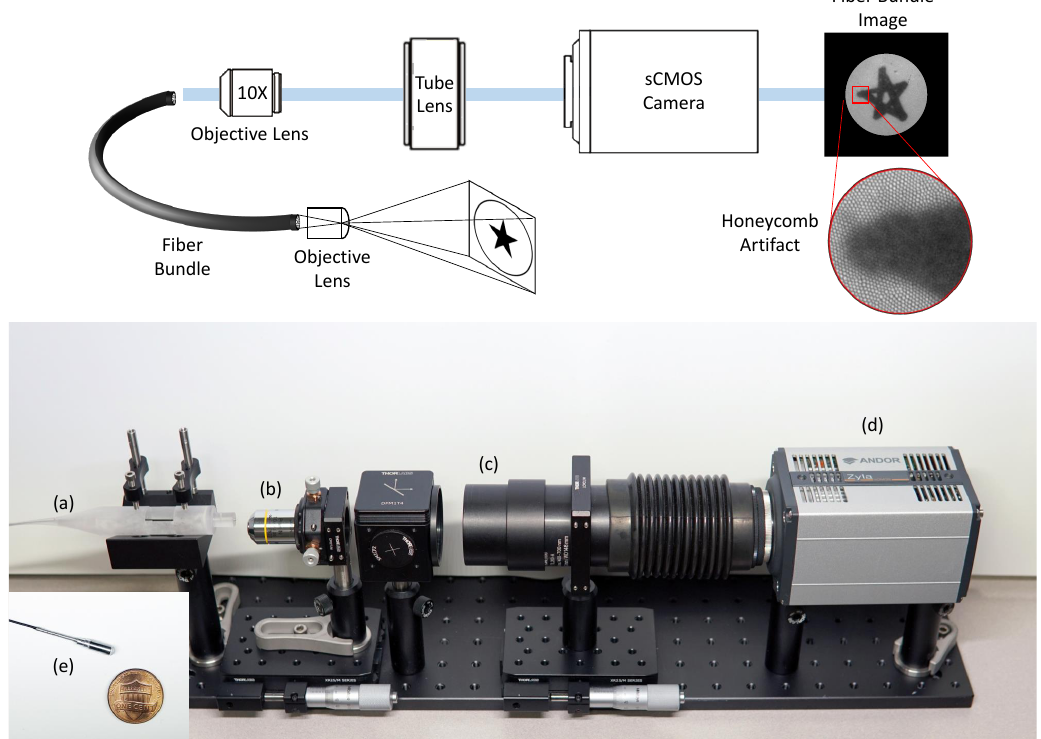
Figure 3. Hardware setup for the fiber bundle imaging system. ( a ) the proximal end of the fiber bundle, ( b ) objective lens (10 × ), ( c ) tube lens, ( d ) sCMOS camera, and ( e ) the distal end of the fiber